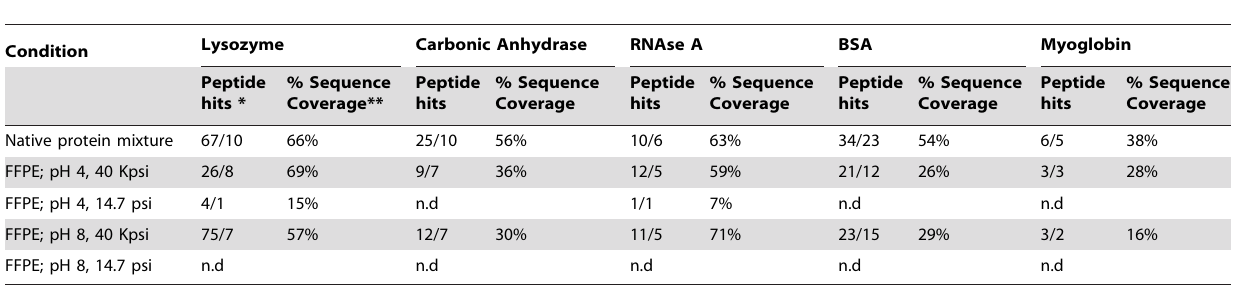
Table 2. LC/MS analysis for a 5-protein FFPE tissue surrogate extracted under atmospheric or elevated hydrostatic pressure.